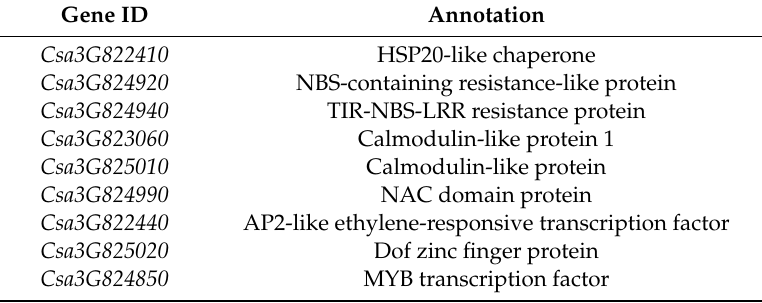
Table 3. Annotation of candidate genes involve in thermotolerance within major QTL qHT3.2 .